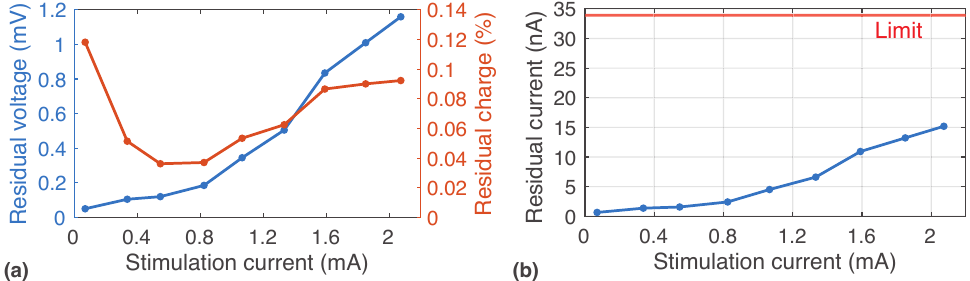
Figure 12. ( a ) Measured residual voltage and residual charge stored at C dl after biphasic stimulation rounds with no discharging phase. T an / ca = T int = 200µs. ( b ) Average residual current, as defined in [29].